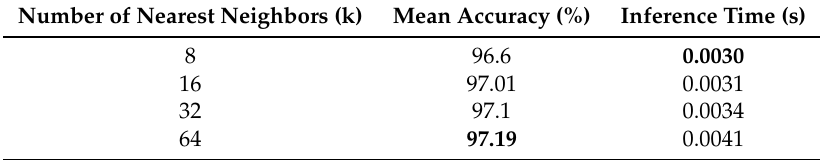
Table 3. Comparison of our model with different numbers of nearest